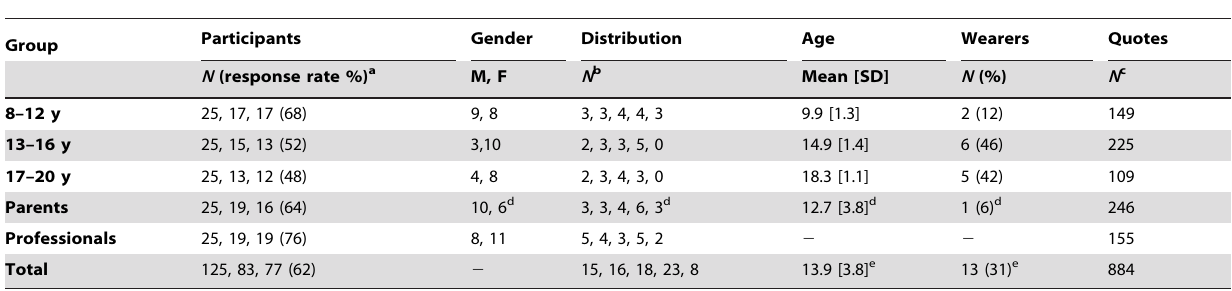
Table 1. Characteristics of participants of online focus